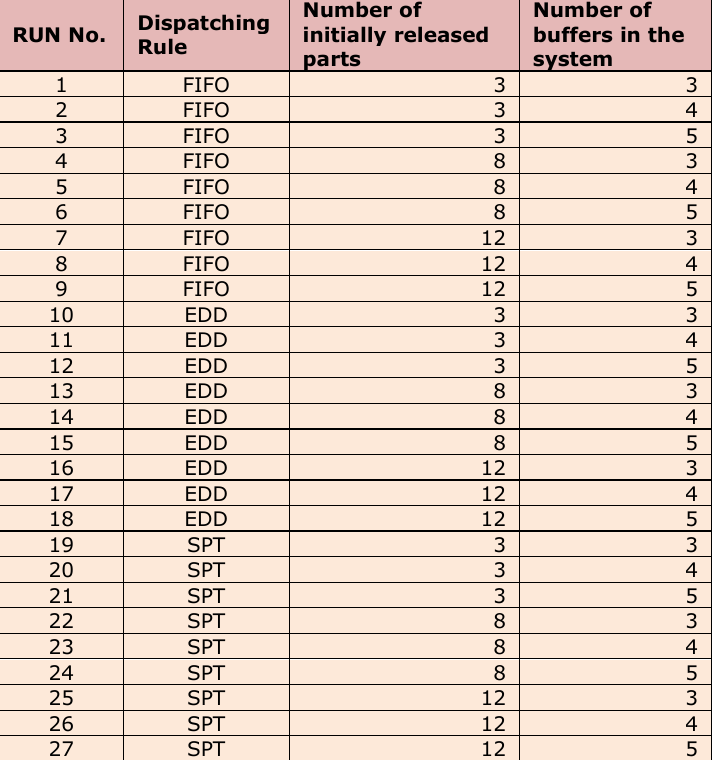
Table 2. Set-up of the Experimental Design